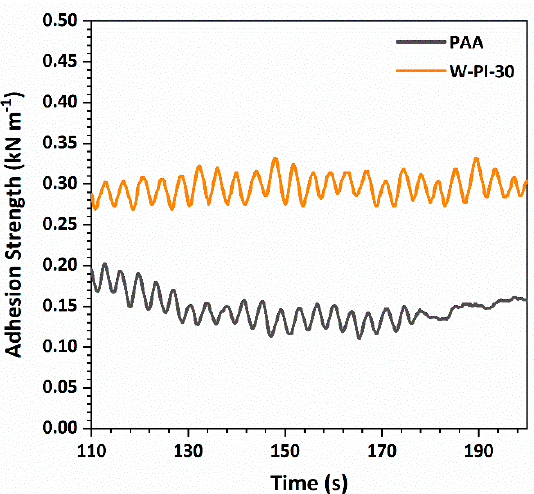
Figure 6. Adhesion strength of Si electrodes with PAA and W − PI − 30 binders measured using SAICAS.